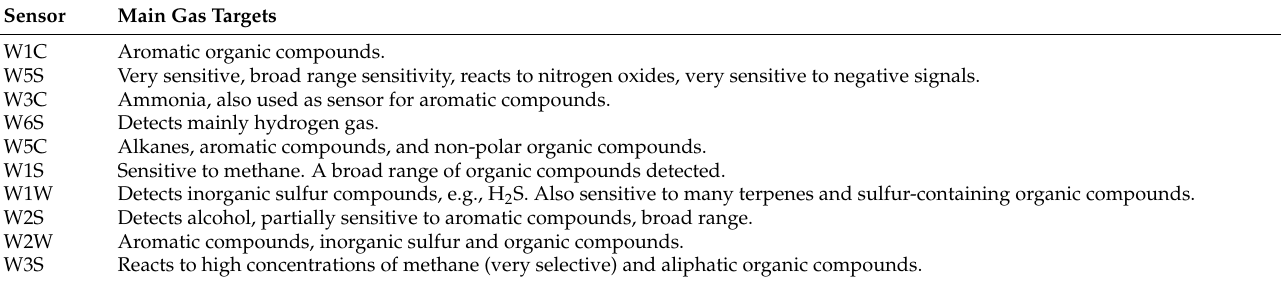
Table A1. Sensor array details in PEN3 electronic nose device, as reported in the menu of options of the electronic nose software.